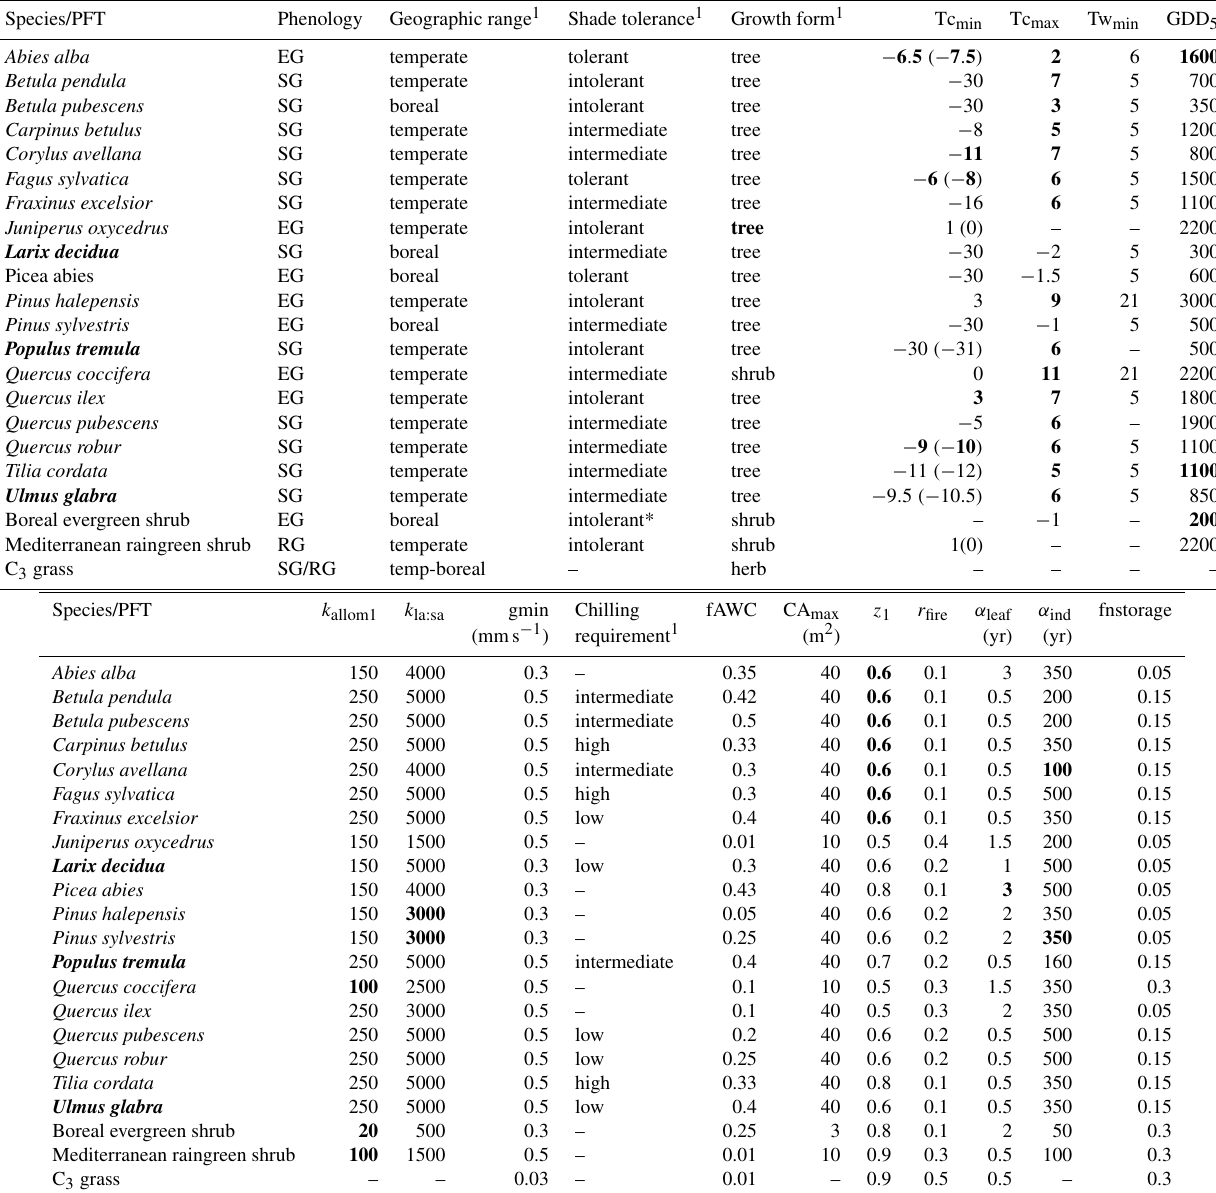
Table A1. PFT parameters used in this study. Values in bold text are updated compared to Hickler et al.